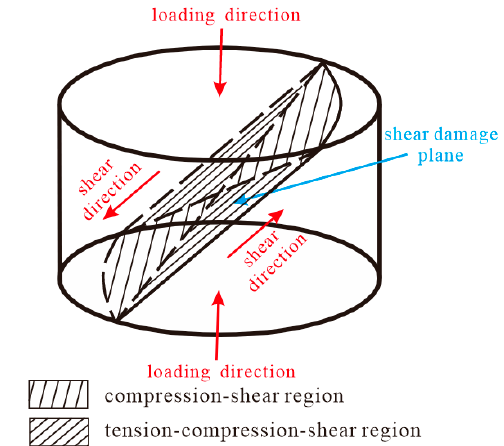
Figure 13. Schematic diagram of the compression instability of the sample.